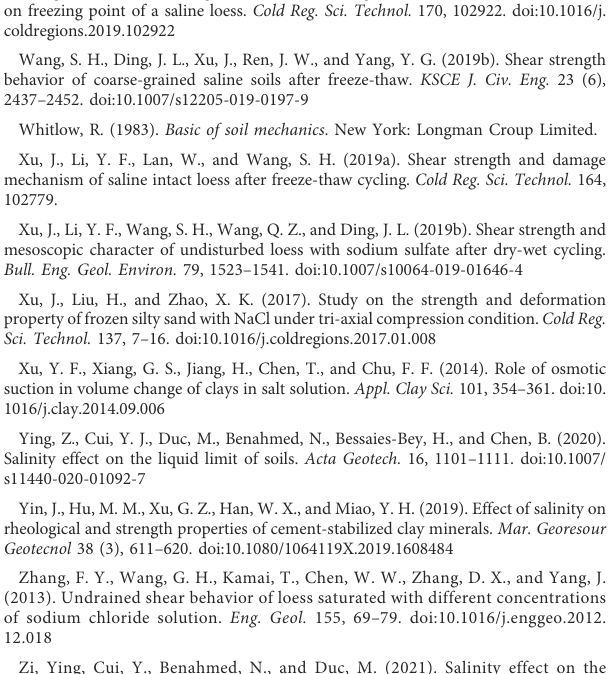
Tabiatnejad, B., Siddiqua, S., and Siemens, G. (2016). Impact of pore fl uid salinity on themechanical behavior ofunsaturatedbentonite – sandmixture. Environ. EarthSci. 75,